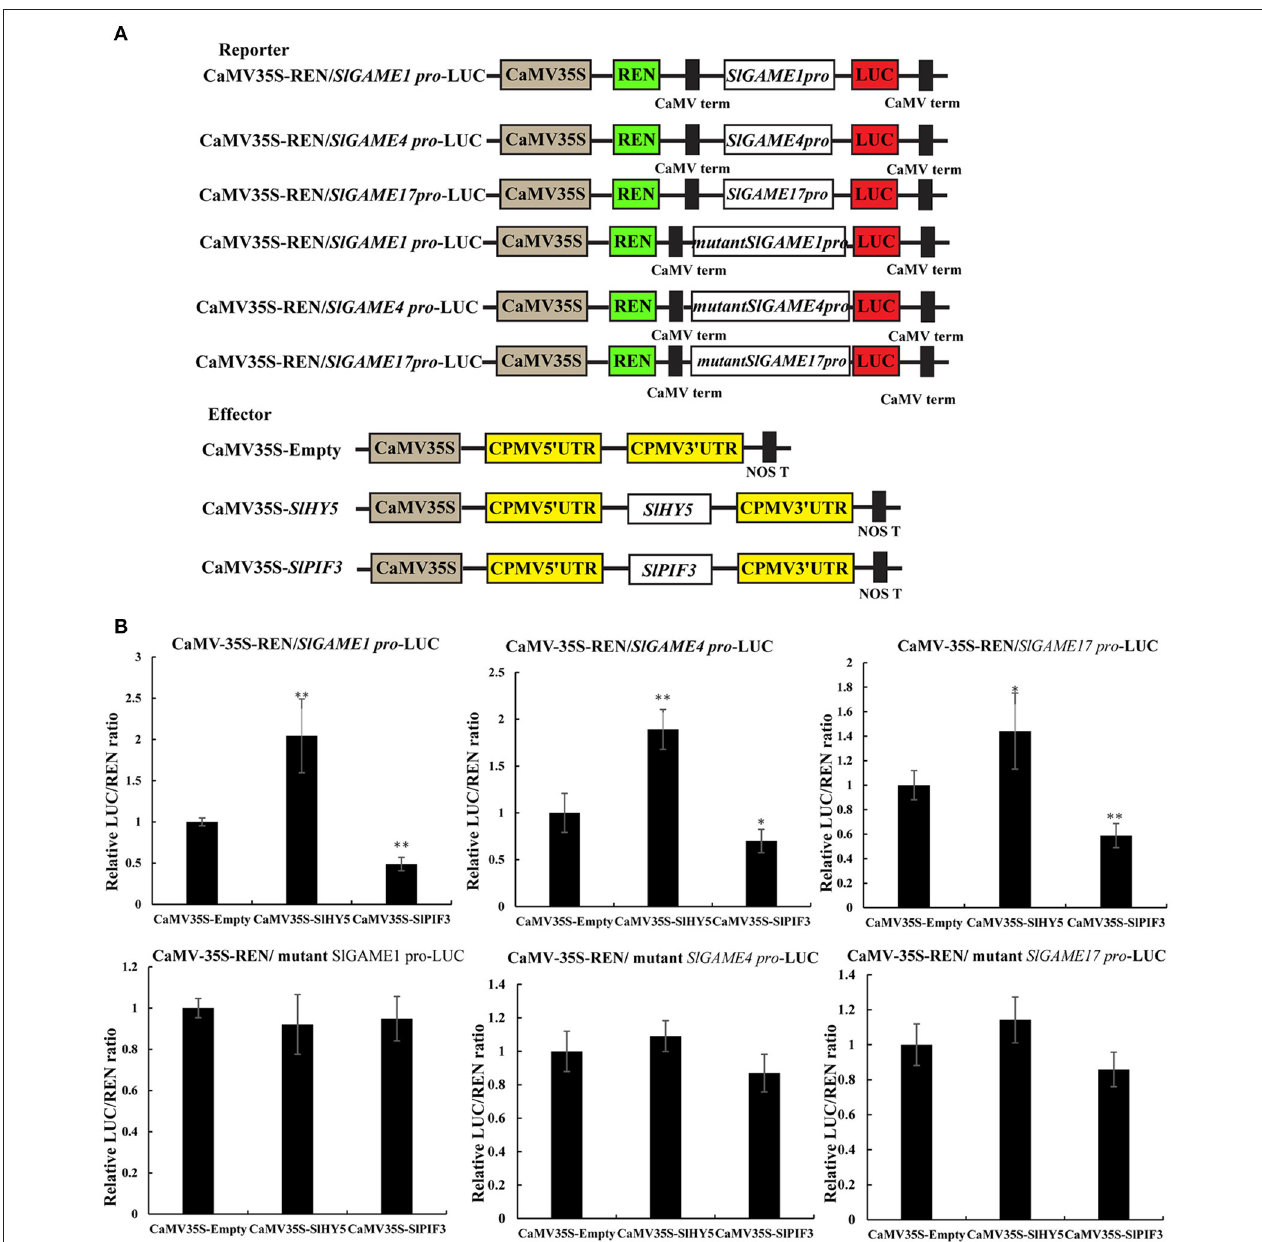
FIGURE 8 | Transient expression analysis of the transcriptional activity of SlPIF3 and SlHY5. (A) Schematic representation of the double reporters and effector plasmids used in the assay. (B) Transcriptional activation ability of SlHY5 and transcriptional repression ability of SlPIF3 in tomato leaves. Each value represents the means ± standard deviation ( n = 6). Asterisks indicate significant differences in values (* P < 0.05; ** P < 0.01; Student’s t -test).